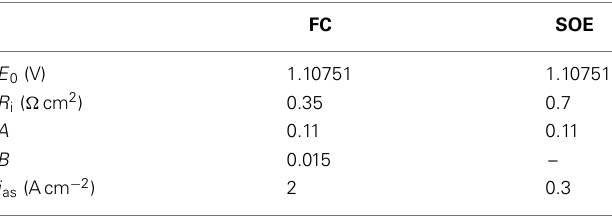
Table 2 | Nernst potential and fitted parameters of a microtubular anode-supported cell operated both in SOFC and SOEC mode